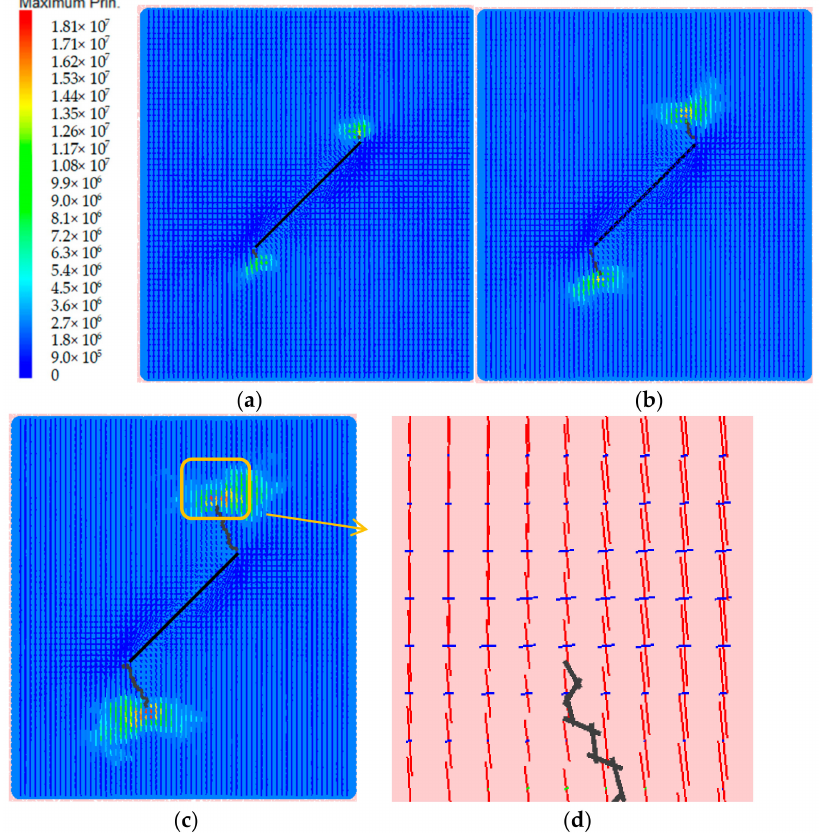
Figure 10. Temporal evolution of principal stress contour in pre-existing crack area: ( a ) σ = σ ci ; ( b ) σ ci < σ < σ cd ; ( c ) σ = σ cd ; ( d ) σ = σ cd